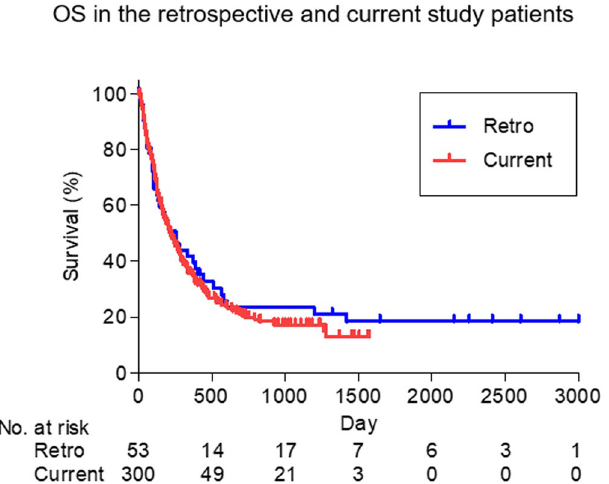
Figure 3. OS rates of overall patients in the current and retrospective studies. OS rates of overall patients in both studies were almost identical ( P = 0.5429). Statistical analyses were performed using GraphPad Prism 5 (https ://www.graph